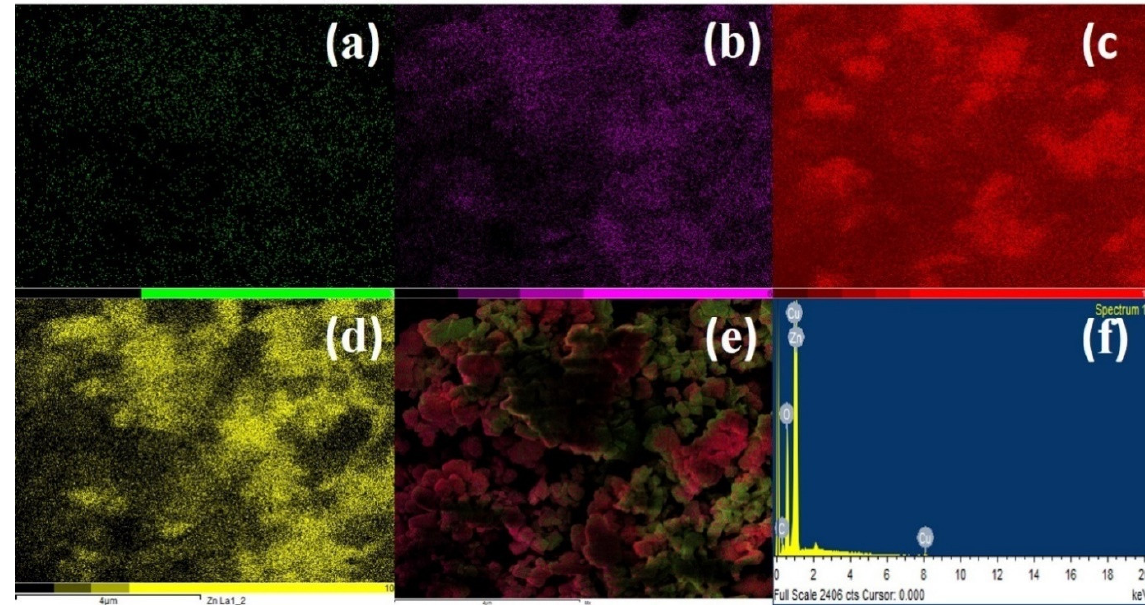
4 of 12 Figure 3. Transmission electron microscopy (TEM) images of rGO@ZnO–Cu nanocomposites at different magnifications. ( a ) 1μm magnification; ( b ) 500 nm magnification and ( c ) 200 nm mag- ni-fication. 2.2. Antibacterial Activity The antimicrobial activity of the nanocomposites Cu, ZnO, and rGO@ZnO–Cu was determined on agar plates using the agar well diffusion assay (Table 1), where the anti- microbial activity was seen in the form of an empty zone around the well of agar media ( Figure 5).The maximum antibacterial activity was observed with rGO@ZnO–Cu, fol- lowed by ZnO and Cu. The inhibitory effect of rGO@ZnO–Cu was stronger against